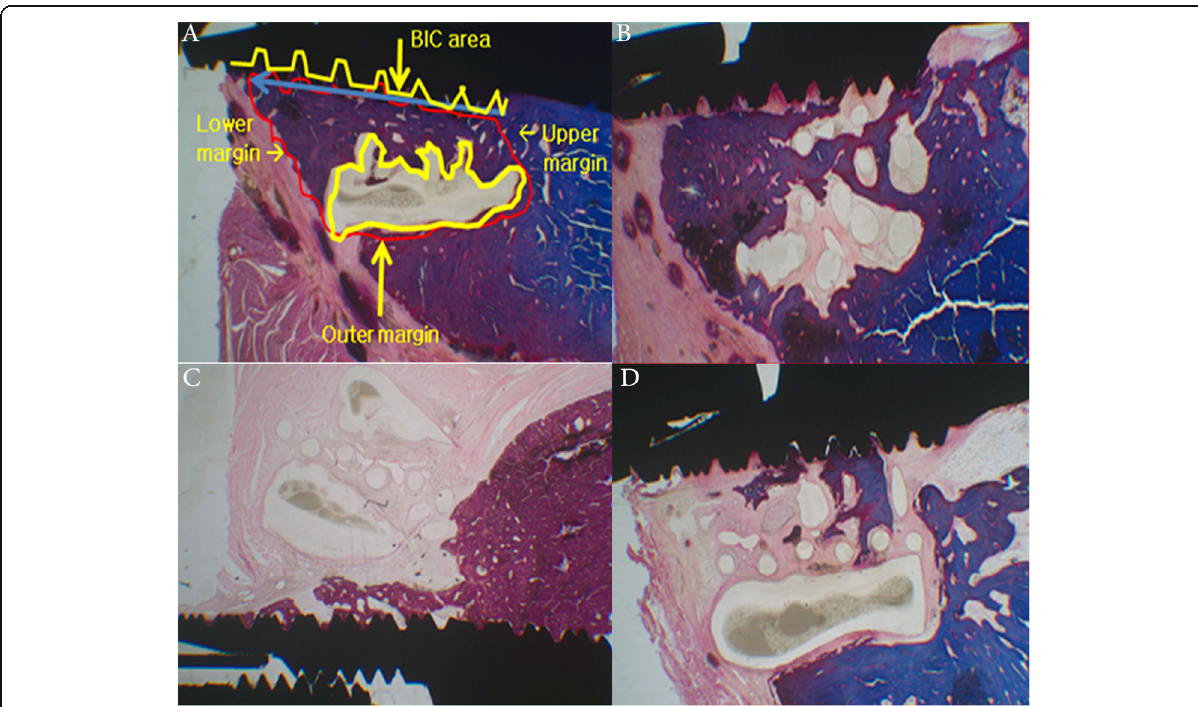
Fig. 5 Histomorphometric analysis. a Parameters of histomorphometric analysis; new bone height (mm, blue line), new bone area (mm 2 , red polygonal area), bone-implant contact (red/yellow length ratio), and residual scaffold area (mm 2 , yellow polygonal area). b – d Microphotograph of the histological structure showing new regenerative bone along the implant contact surface with degradation of the scaffold at b MSCs+PRP+PCL-TCP, c PRP+PCL-TCP, and d PCL-TCP groups,